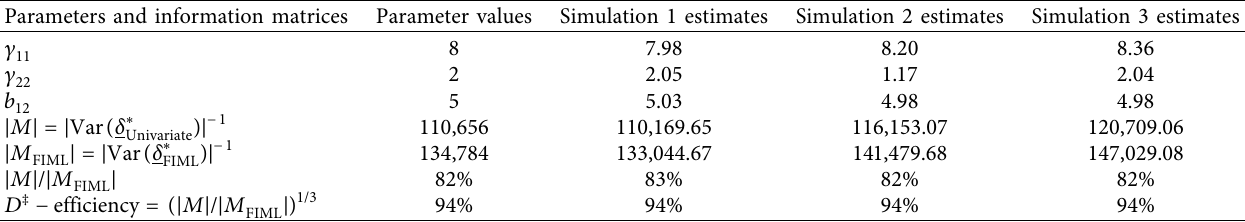
Table 5: Parameter values, estimates, determinants of information matrices, their ratios, and D -efficiency based on a FIML D -optimal design and a univariate optimal design for three